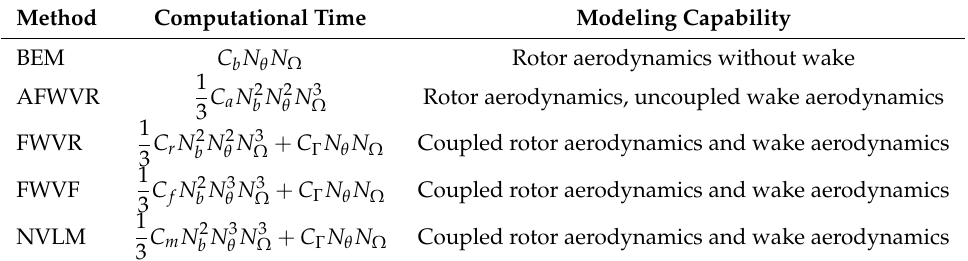
Table 1. Computational time and function of different